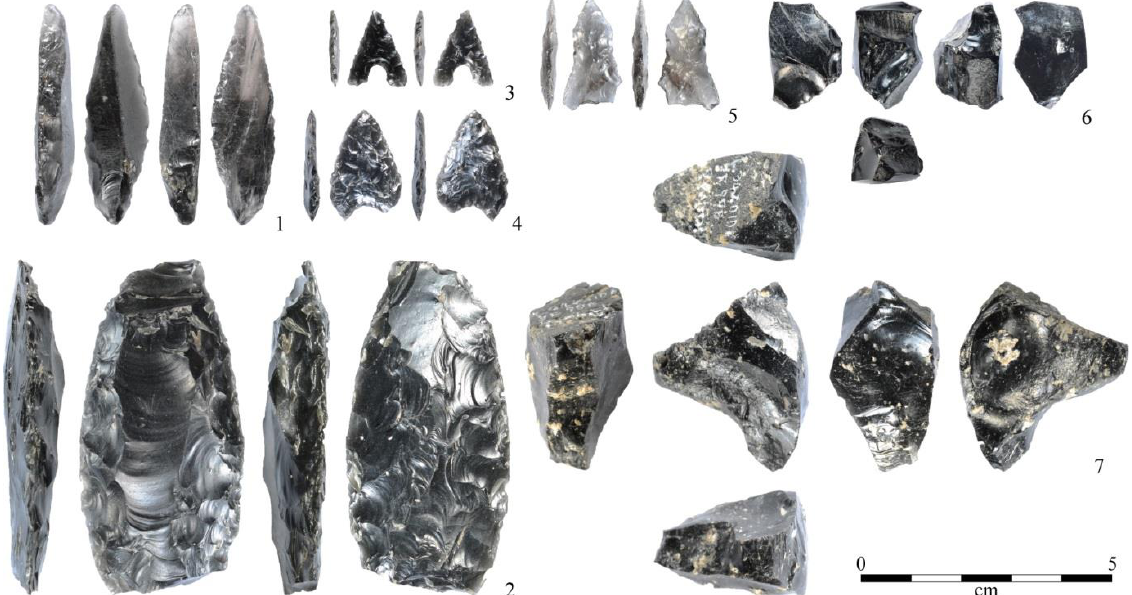
Figure 5. Obsidian artifacts unearthed in Kansai region, Japan (Photography by Masaki Shibata). 1. Backed- blade from the Gokasyo-Futagozuka site, Upper Palaeolithic Period, Nishi-Kirigamine series obsidian (owned by Uji City Board of Education). 2. Point from the Rokuya site, possibly Incipient Jomon Period, Oki Island series obsidian (owned by Kameoka City Board of Education). 3. Arrowhead from the Oyugo-Arahori site, Early Jomon Period, Oki Island series obsidian (owned by Fukuchiyama City Board of Education). 4. Arrowhead from the Keshikedani site, Early Jomon Period, Oki Island series obsidian (owned by Fukuchiyama City Board of Education). 5. Arrowhead from the Kitaochi site, Final Jomon Period, Nishi-Kirigamine series obsidian (owned by Shiga Prefecture Board of Education). 6. Thermal fractured piece from the Ishida site, Final Jomon Period, Osaki Peninsula series obsidian (owned by Muko City Board of Education). 7. Thermal fractured piece from the Kaide site, Final Jomon Period, Koshidake series obsidian (owned by Muko City Board of